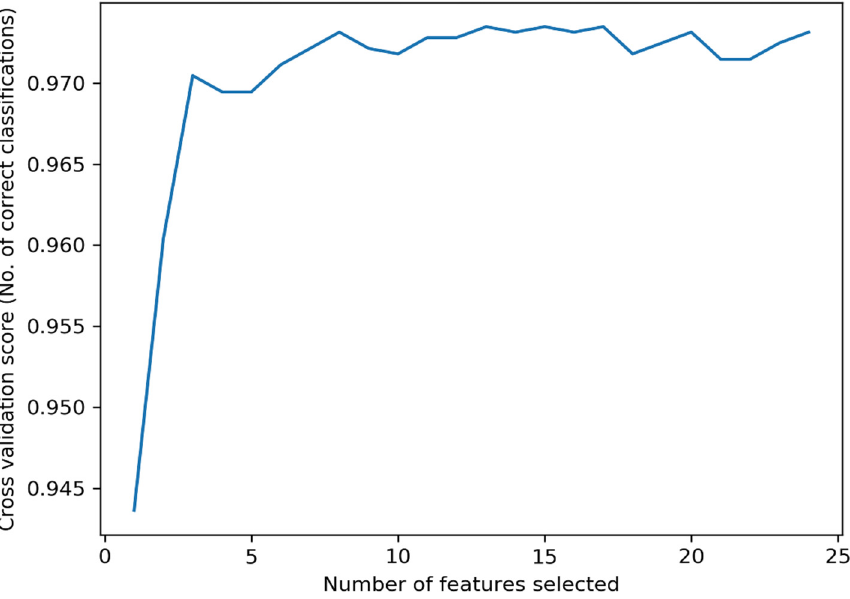
Figure 4. Feature selection results using the RFECV algorithm on the training set. The best results occur when the number of features is 13.